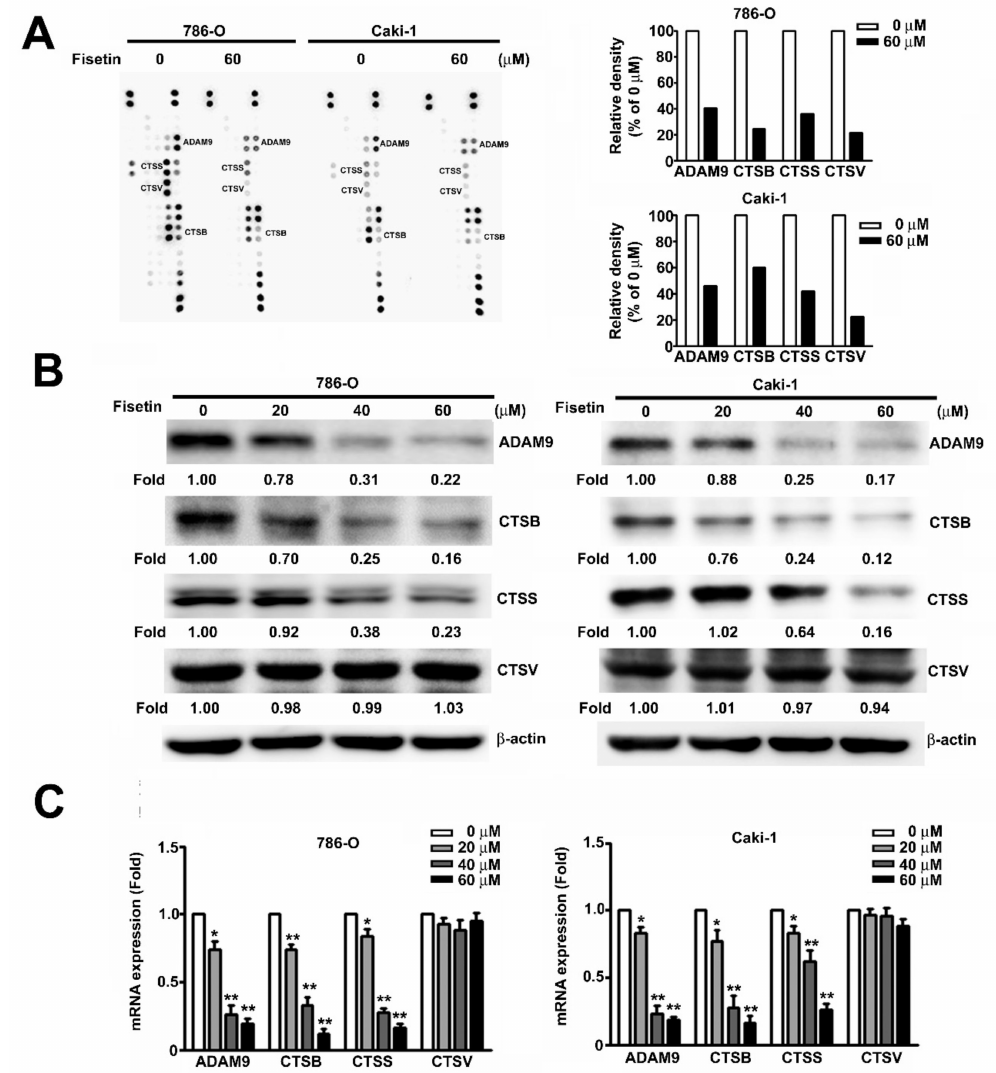
Figure 4. E ff ects of fisetin on the expression of CTSB, CTSS, CTSV, and a disintegrin and metalloproteinase (ADAM)9 in RCC cells. ( A ) A human protease array profile was performed on whole cell lysate from 786-O cells and then incubated with 0 and 60 µ M fisetin for 24 h. Spots for CTSB, CTSS, CTSV, and ADAM9 were marked. The right panel shows the quantification of individual spot intensities compared with the control (0 µ M). ( B ) 786-O cells were incubated with various concentrations (0, 20, 40, and 60 µ M) of fisetin, and total cell lysates were then analyzed through Western blotting to determine the expression of CTSB, CTSS, CTSV, and ADAM9 proteins. β -actin was used as an internal control for protein, with equal loading. ( C ) The expression of CTSB, CTSS, CTSV, and ADAM9 mRNA was verified using qRT-PCR. Data are presented as the mean ± SE of at least three independent experiments. * p < 0.05, ** p < 0.01 compared with the untreated control (0 µ